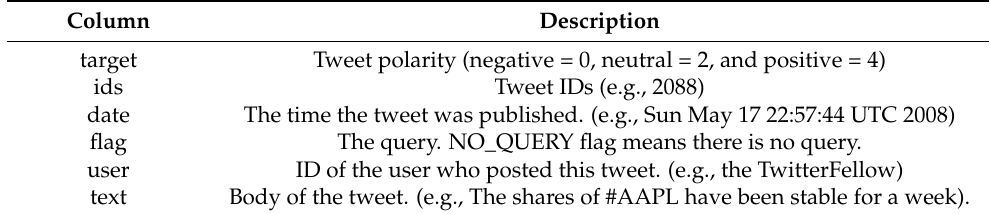
Table 5. Description of the Sentiment140 dataset.